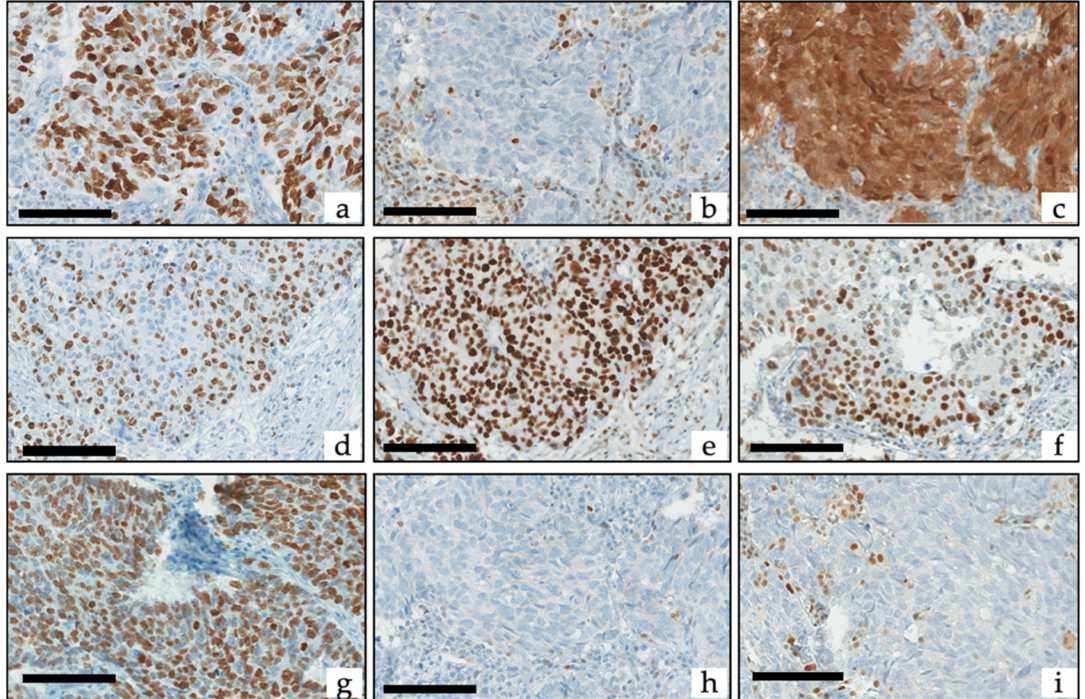
Figure 1. Example of Ki-67, retinoblastoma protein (Rb), p16 and p53 immunohistochemistry: ( a – c ) SCNEC with ( a ) Ki-67 at 90%, ( b ) loss of Rb (with positive internal controls) corresponding to the absence of Rb staining (Rb inap ) pattern, and ( c ) high expression of p16 corresponding to the intense p16 staining (p16 high ) pattern. ( d – f ) LCNEC with ( d ) Ki-67 at 60%, ( e ) diffuse overexpression of p53 corresponding to the inappropriate p53 staining (p53 inap ) pattern, and ( f ) conserved expression of Rb corresponding to the appropriate Rb staining (Rb app ) pattern. ( g – i ) SCNEC with ( a ) Ki-67 at 83%, ( h ) complete loss of p53 (with positive internal controls) corresponding to the p53 inap pattern, and ( i ) loss of Rb (with positive internal controls) corresponding to the Rb inap pattern. Scale bars correspond to 50 µ